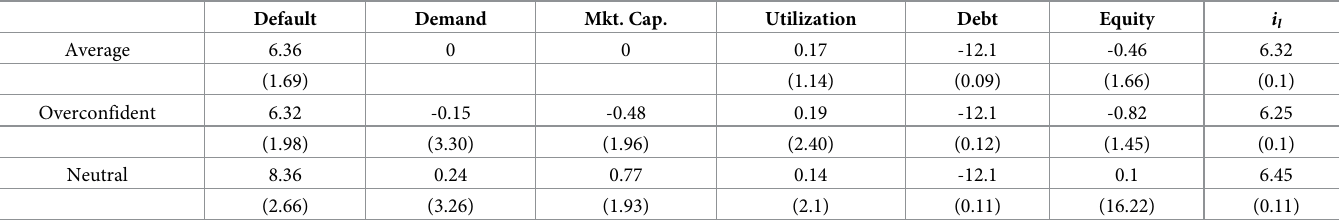
Table 4. Shock on parameter i cb